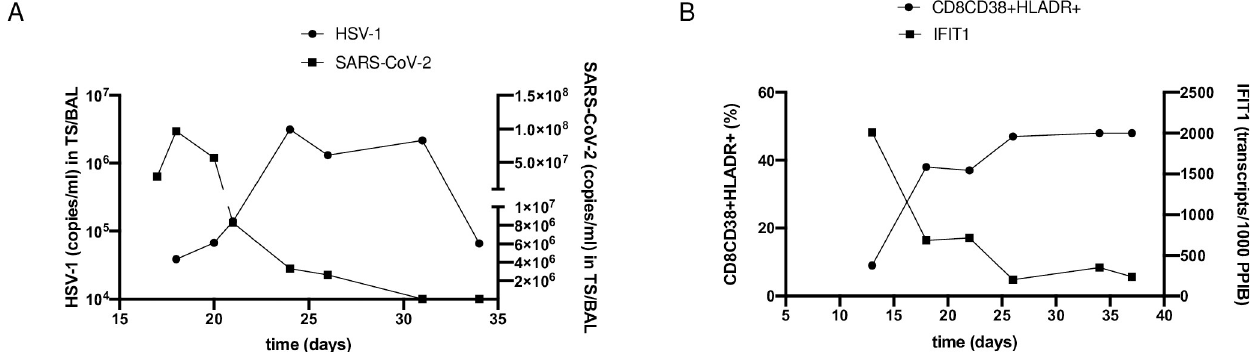
Fig 7. Time course of viral load of HSV-1 (copies/ml) and SARS-CoV-2 (copies/ml) in TS/BAL (A) , CD8CD38+HLADR+ (%) and IFIT1 (transcripts/1000 PPIB) (B) exemplarily illustrated for one patient.